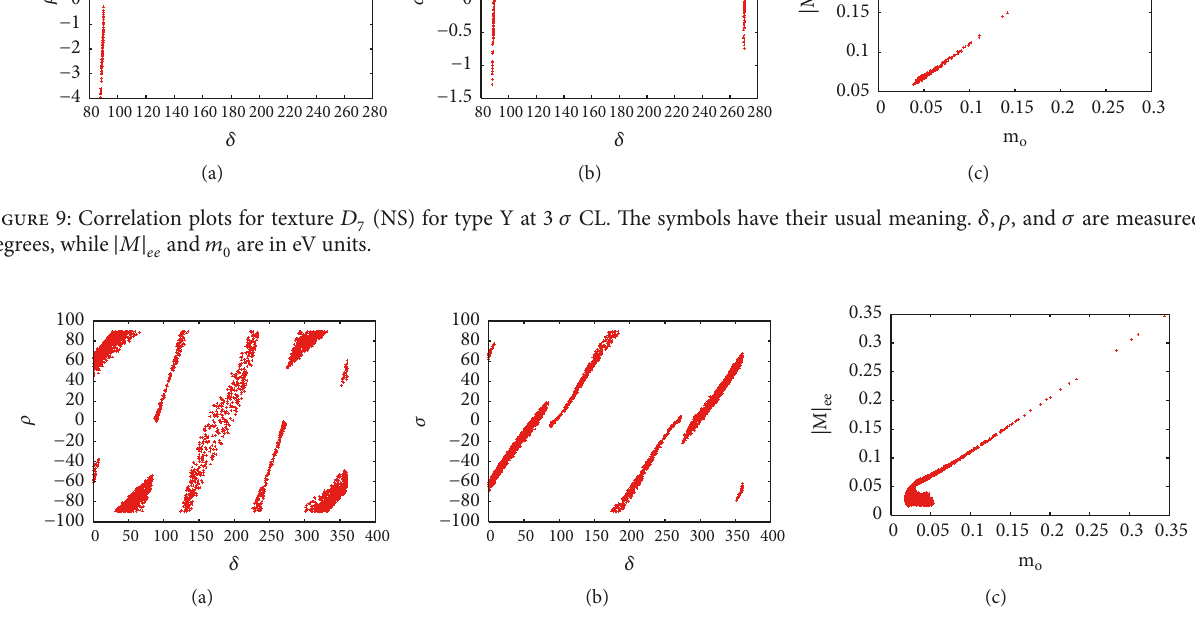
Figure 10: Correlation plots for texture 𝐷 7 (IS) for type Y at 3 𝜎 CL. The symbols have their usual meaning. 𝛿,𝜌 , and 𝜎 are measured in degrees, while |𝑀| 𝑒𝑒 and 𝑚 0 are in eV units.